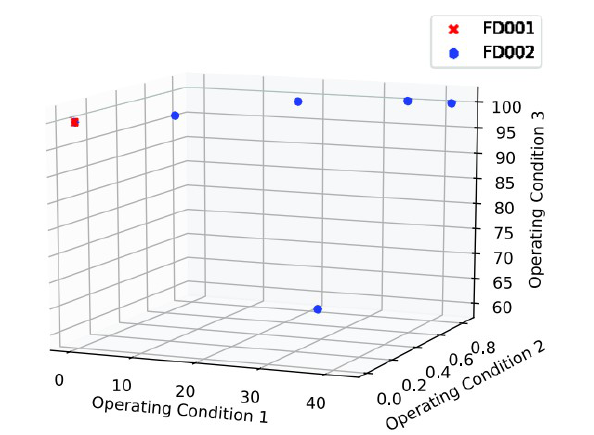
Figure 9. FD001, FD002 operating